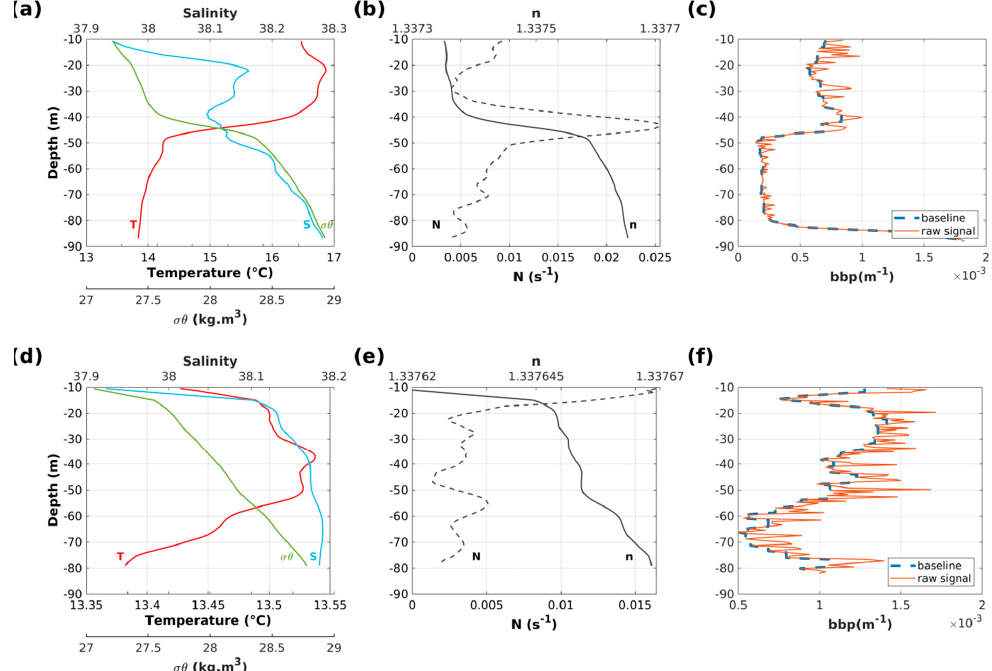
Figure 2. ( a , d ) Water-column profiles of salinity (S), temperature (T), and density ( σθ ); ( b , e ) index of refraction of seawater (n) and Brunt–Väisälä frequency profiles (N); and ( c , f ) backscattering profiles of bbp 700 of Wetlabs BBFL2 (raw-signal) and the baseline extract from a filter 5-point running minimum followed by a 5-point running maximum applied on the bbp 700 measurements. The top panels correspond to the autumnal season (November, 2016) showing a seasonal thermocline around 50 m depth characteristic of the coastal area surrounding the Rhone region of freshwater influence (ROFI) area. The lower panels correspond to the winter season, with a homogeneous water column (15–80 m depth), except in subsurface waters due to the Rhone River plume. Spike analyses: spikes were recorded by all optical measurements as rapid, transient, and often large increases in optical signals. Spikes result from the interception by optical instruments of coarse particles, such as aggregates and biological debris [24], which are scarce relative to the fine particles that induce most of the turbidity signal. We used a similar spikes analysis on our data to characterize the presence of large particles (Figure 2c–f). A 5-point running minimum filter followed by a 5-point running maximum was applied on the raw optical backscattering data at 700 nm (one measurement